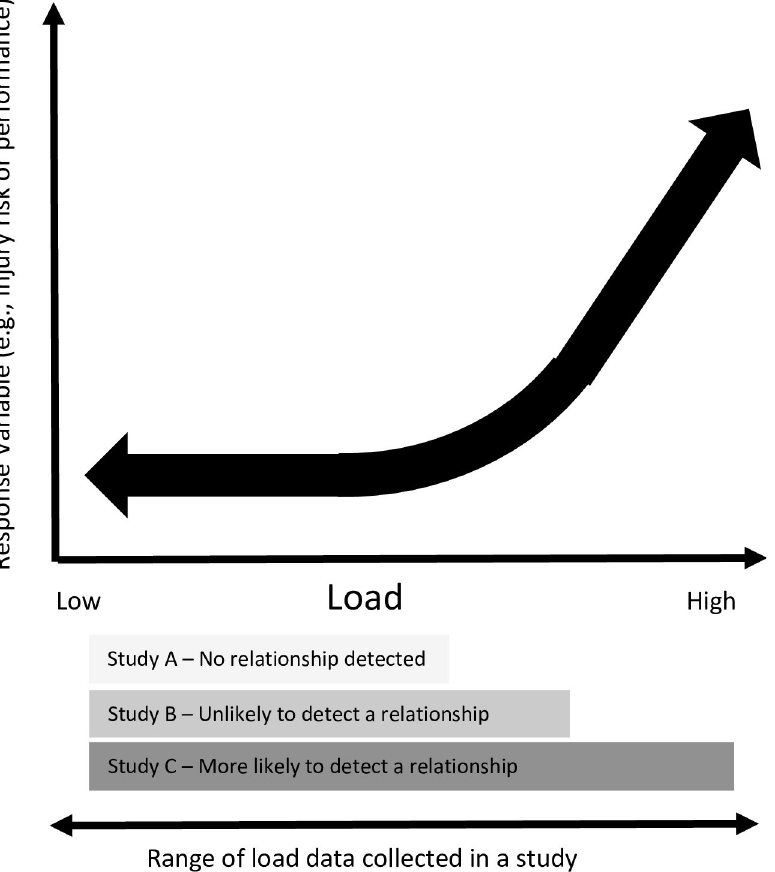
Fig 1. An example of the risks associated with analysing unrepresentative load data. This chart provides a conceptual illustration of a relationship between load and a response variable which could be a change in a component of fitness or injury risk. The horizontal bars represent the range of a load measure for three hypothetical studies. Each study’s unique range of load influences whether a relationship with the response variable would be detected in an analysis of the